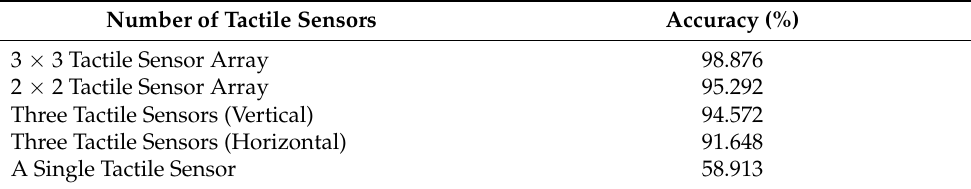
Figure 5. Tactile sensors used as inputs to the neural network for investigating the effect of sensing tactile array on texture recognition. With single tactile sensing, the data from one sensor located at the center of a 3 × 3 tactile sensor array were used. To investigate the effect of the arrangement of sensors on texture recognition using the same number of tactile sensors, sensors were used consisting of three vertical sensors passing through the center and three horizontal sensors passing through the center. The sensor located on the remaining side of the gripper was also used in the same manner. Table 1. Accuracy results of texture classification according to the number of tactile